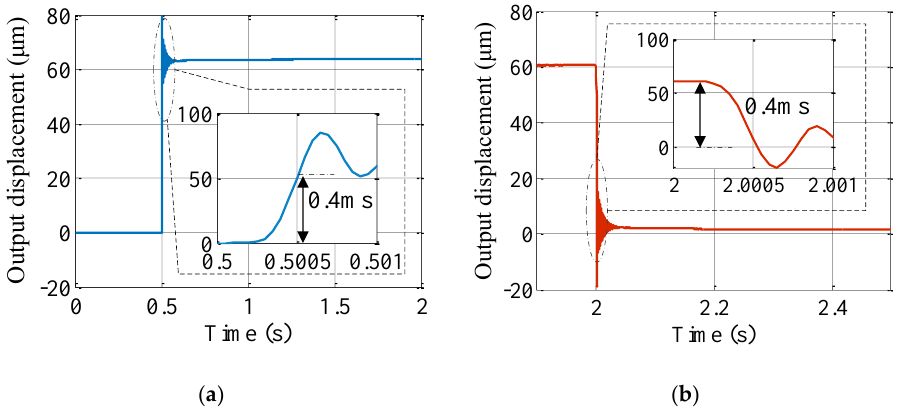
Figure 16. Experimental results of the step response for the presented displacement amplification mechanism. ( a ) Step increasing. ( b ) Step reducing. mechanism. ( a ) Step increasing. ( b ) Step reducing. Table 5. Comparison on the static and dynamic performances of different amplified piezoelectric actuators.